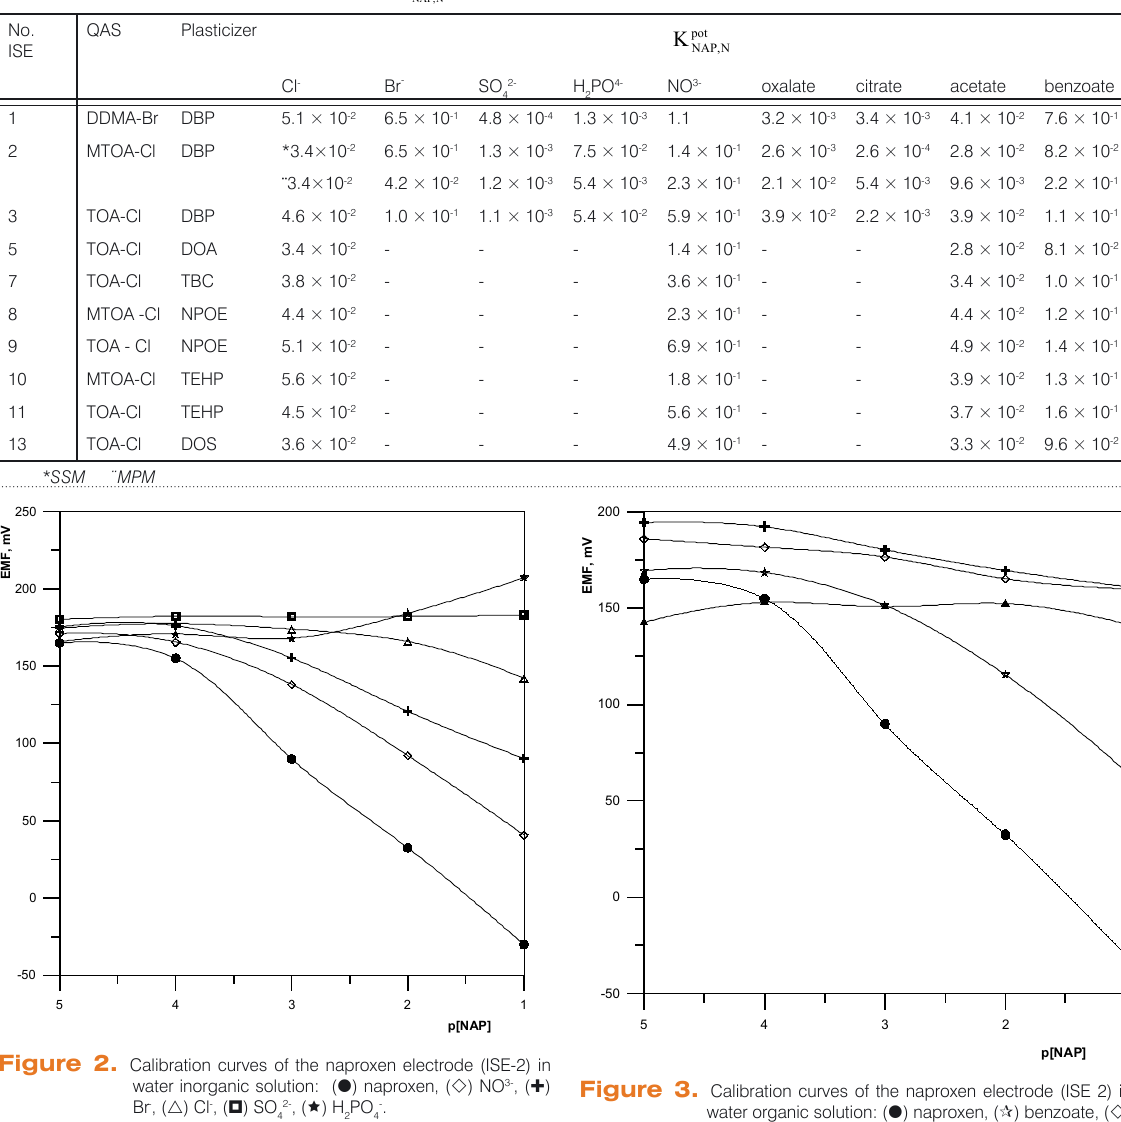
, of naproxen NNAP, K